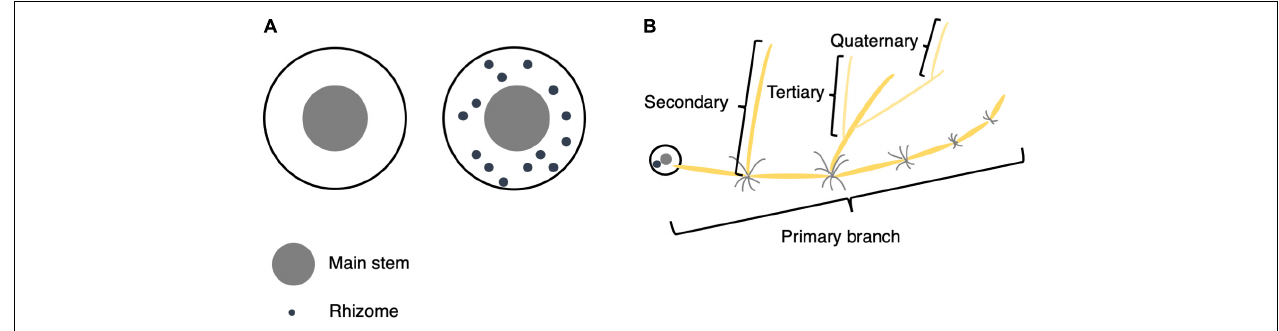
FIGURE 1 | Phenotypic evaluation of rhizomes. (A) Top view of plants with and without rhizomes. If a plant’s underground part contained only the main stem and tillers, its Rhz was recorded as 0 (without rhizomes), and if there were obvious internodes in the underground part, its Rhz was recorded as 1 (with rhizomes). (B) Schematic illustration for primary, secondary, tertiary, and quaternary branches.